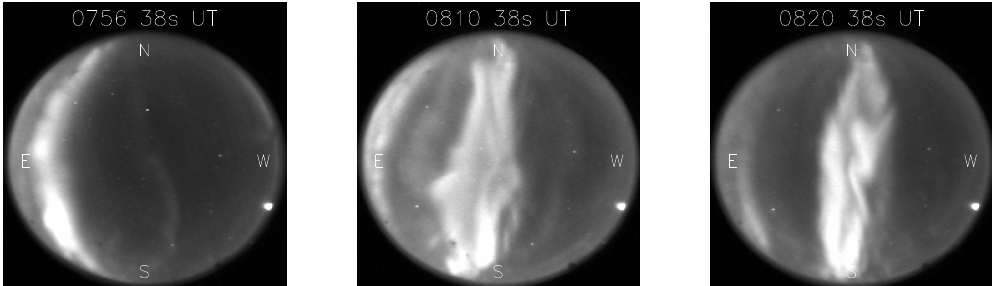
Fig. 2. Three all sky images of sun-aligned auroral forms recorded by the OMTI camera at a wavelength of 630nm at Resolute Bay on 15 February 2007.